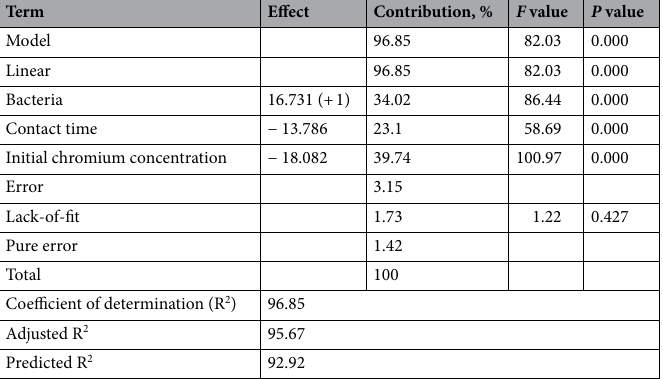
Table 3. The effect, contribution, and corresponding F - and P -values for Cr 6+ removal recovered by P. alcaliphila NEWG-2 using Plackett–Burman